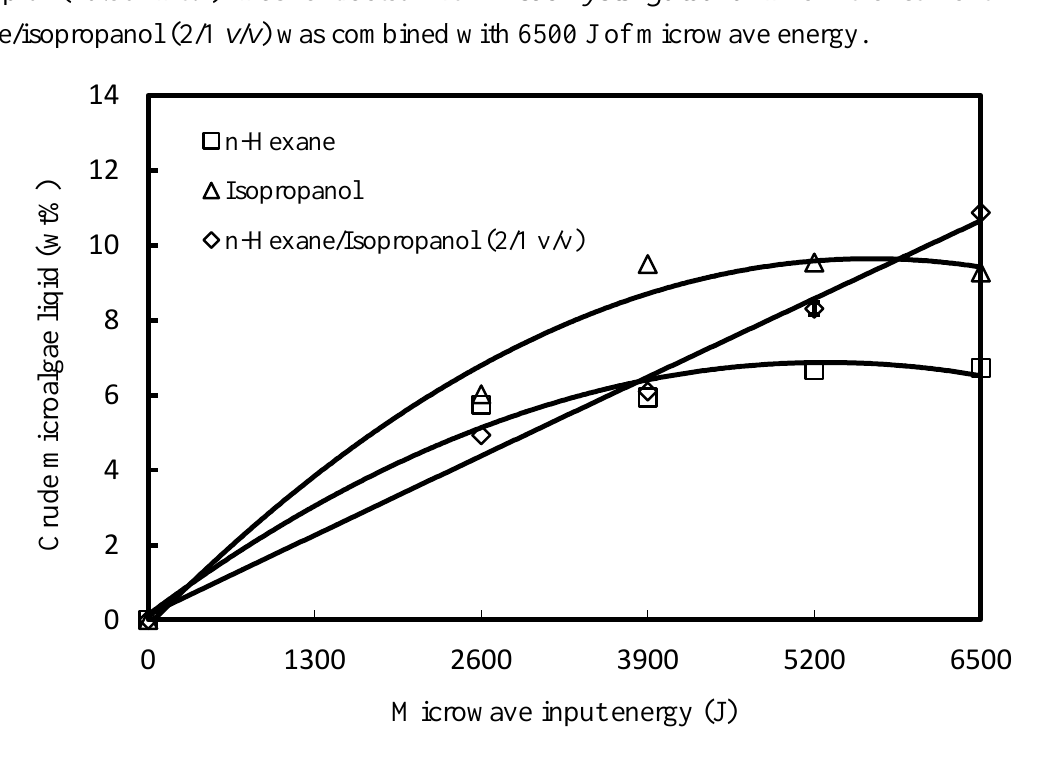
Figure 3. Effects of different organic solvents on the quantity of crude microalgae lipids extracted using the microwave-assisted